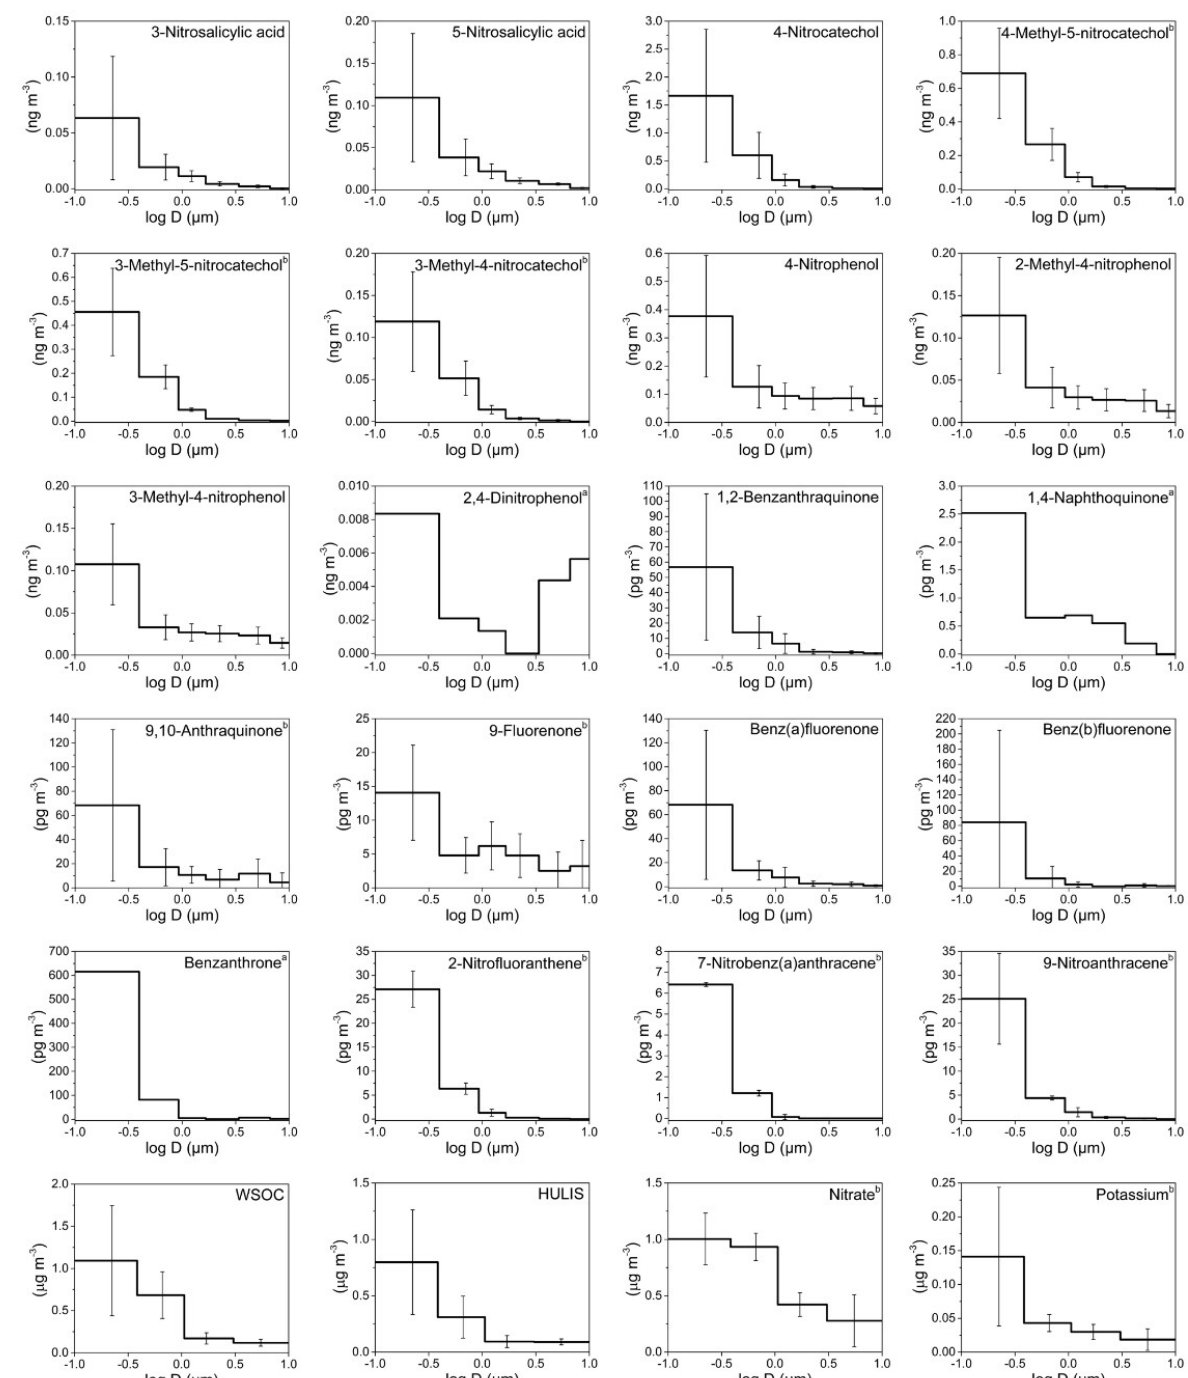
Figure 1. Mass size distributions (MSDs) of PM-bound NMAHs, NPAHs, OPAHs, WSOC, HULIS, and ions in Mainz (Germany). The error bars represent standard deviations. a Compound MSD calculated from one (out of four) sample set (detected and quantified in one sample set only); b compound MSD calculated from three (out of four) sample sets (detected and quantified in three sample sets